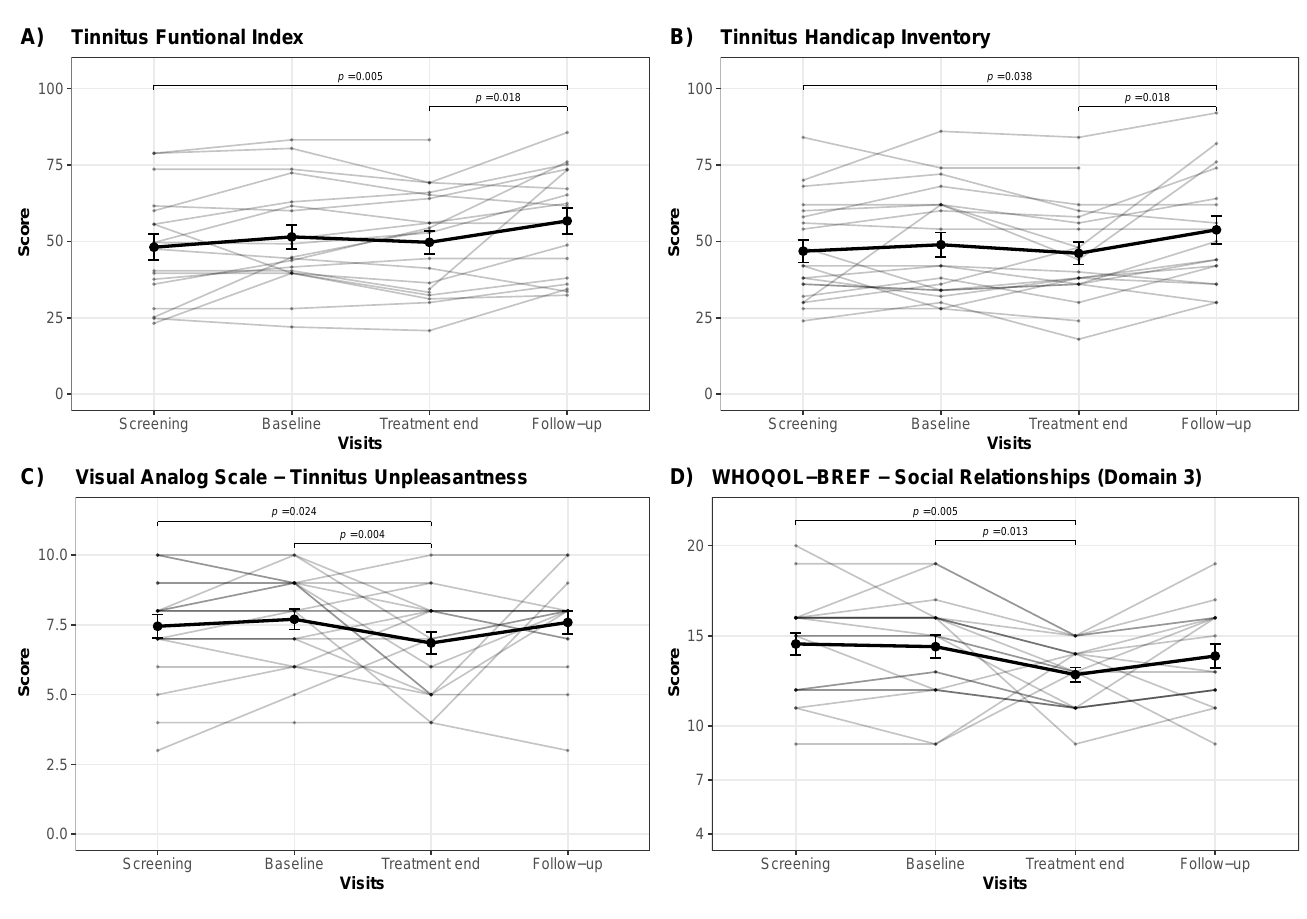
Figure 1. Results of post hoc analysis. Averaged total score changes over the course of all study visits (screening, baseline, treatment end, follow-up) are presented by means of bold lines for the ( A ) Tinnitus Functional Index, ( B ) Tinnitus Handicap Inventory, ( C ) Visual Analog Scale for tinnitus unpleasantness and ( D ) the social relationship domain (domain 3) of the abbreviated version of the World Health Organization Quality of Life questionnaire. Error bars indicate standard errors. Significant differences between study visits are highlighted with bars and the respective p -values. Greyish lines represent the total scores on a single patient